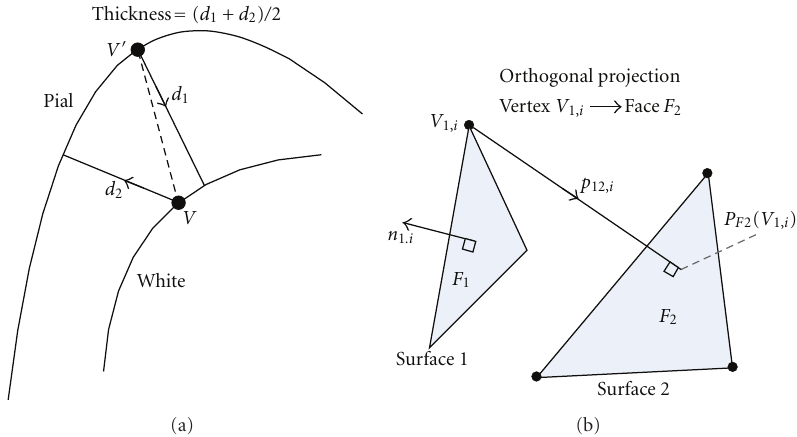
Figure 8: Illustration of two di ff erent approaches of defining a distance between two surface meshes. (a) The thickness measure defined in FreeSurfer (2D schematic drawing). (b) The (signed) distance measure defined by closest orthogonal